Question: Judging by this figure, is the value going up or going down?
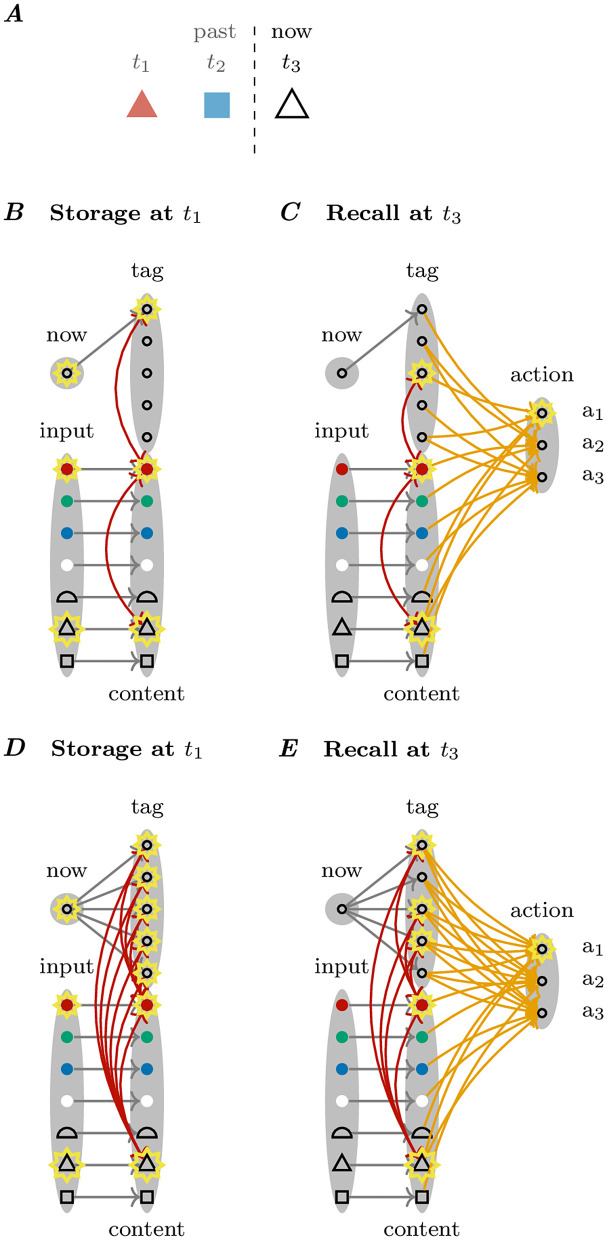
Answer: increasing